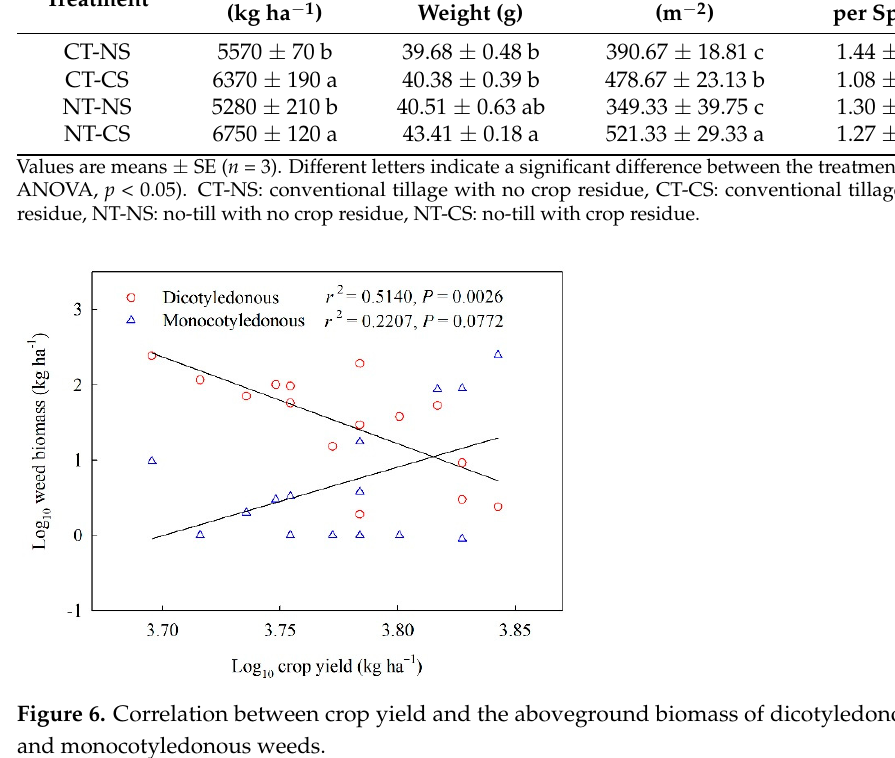
Table 2. Grain yield of winter wheat and its components under different treatments. Grain Yield Treatment